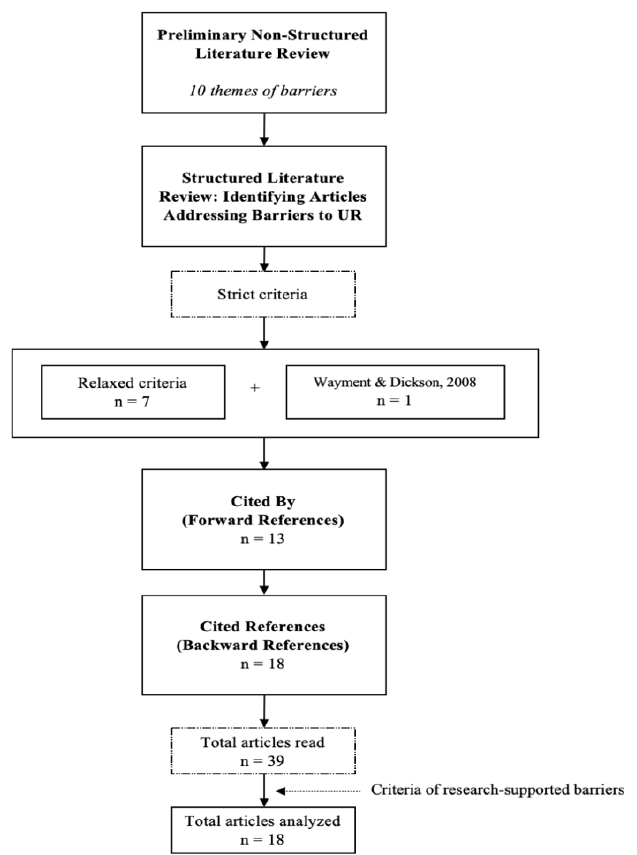
Figure 1. Flowchart outlining the methods and outcomes of our preliminary non-structured liter-ature review and subsequent structured literature review which led to the final number of articles analyzed.